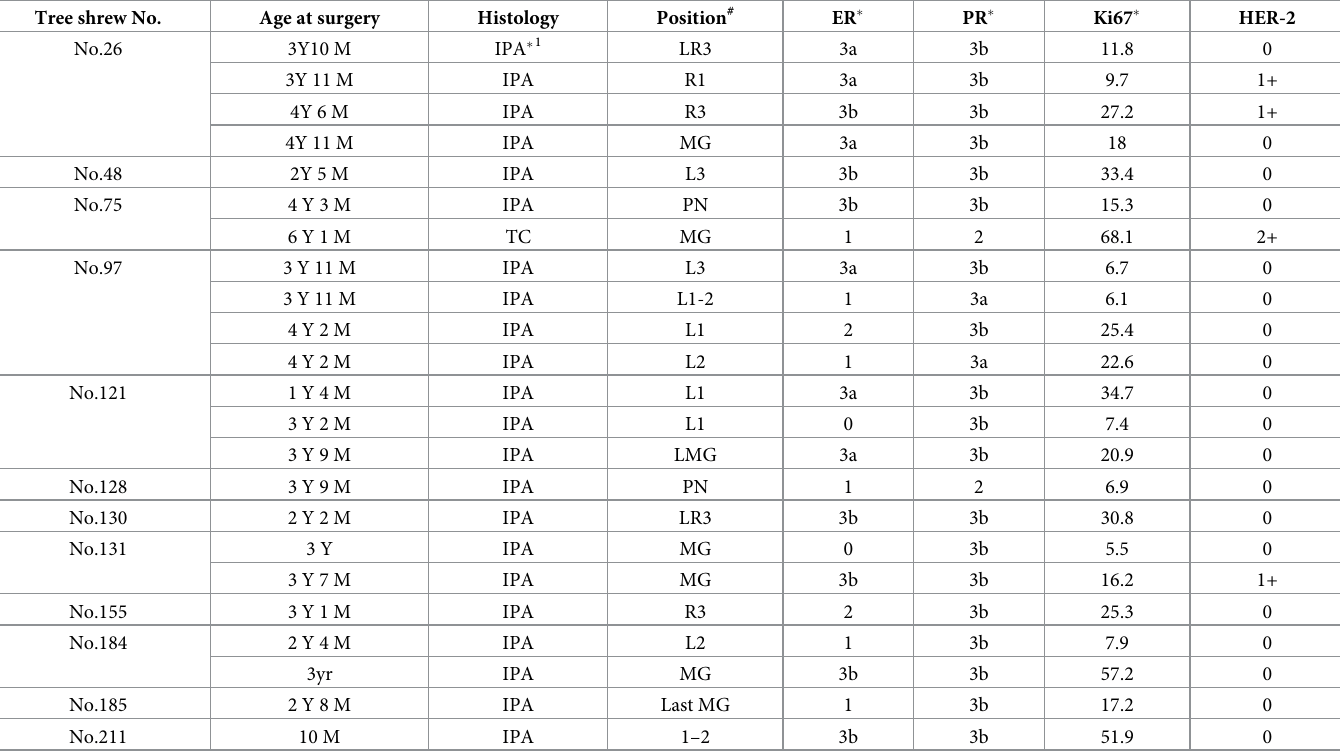
Table 2. Characteristics of tree shrew mammary gland tumors. Tree shrew No.